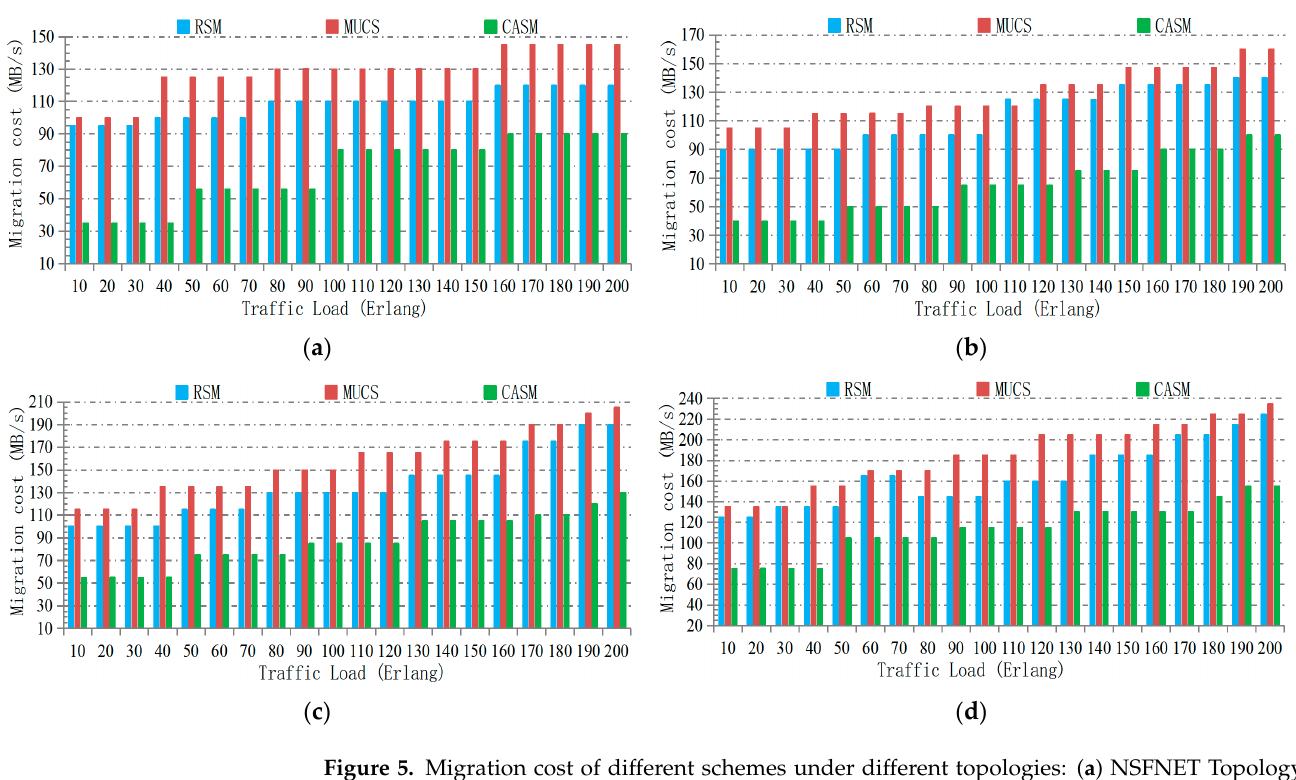
Figure 5. Migration cost of different schemes under different topologies: ( a ) NSFNET Topology; ( b ) OS3E Topology; ( c ) Ta2 Topology; ( d ) Interoute Topology.